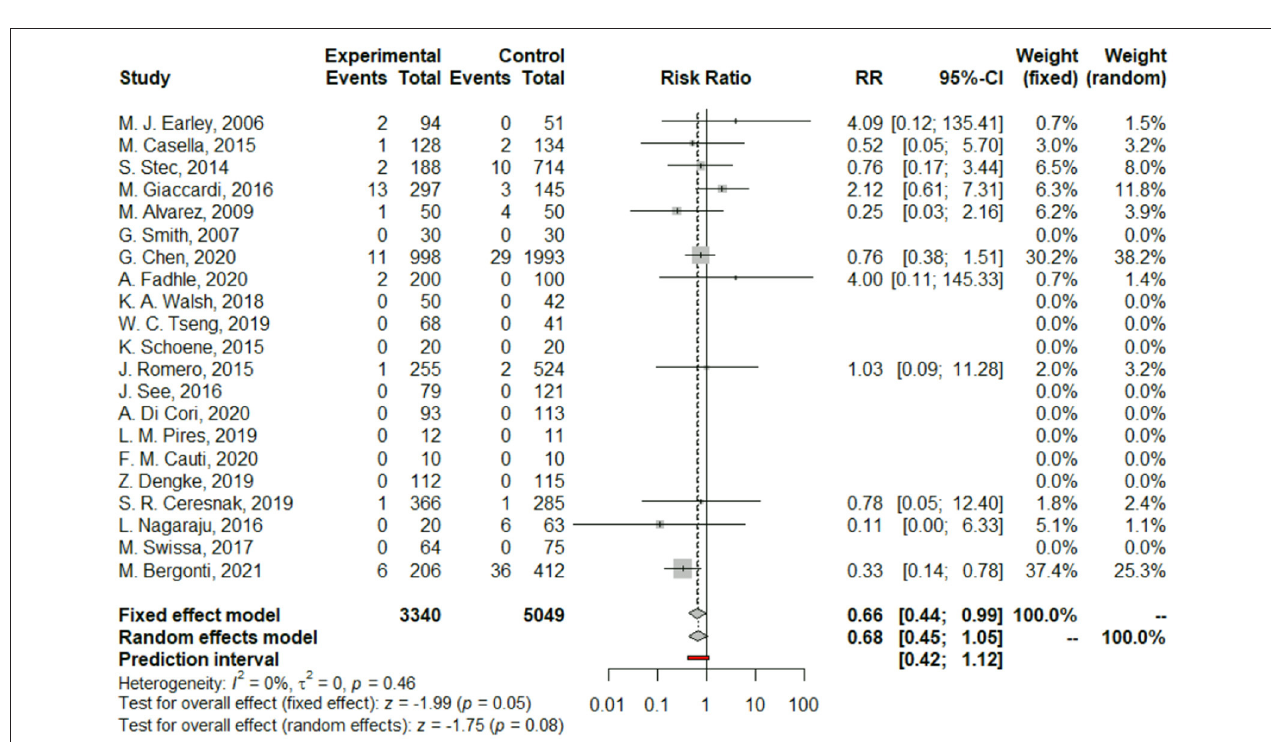
FIGURE 4 | Forest plots of